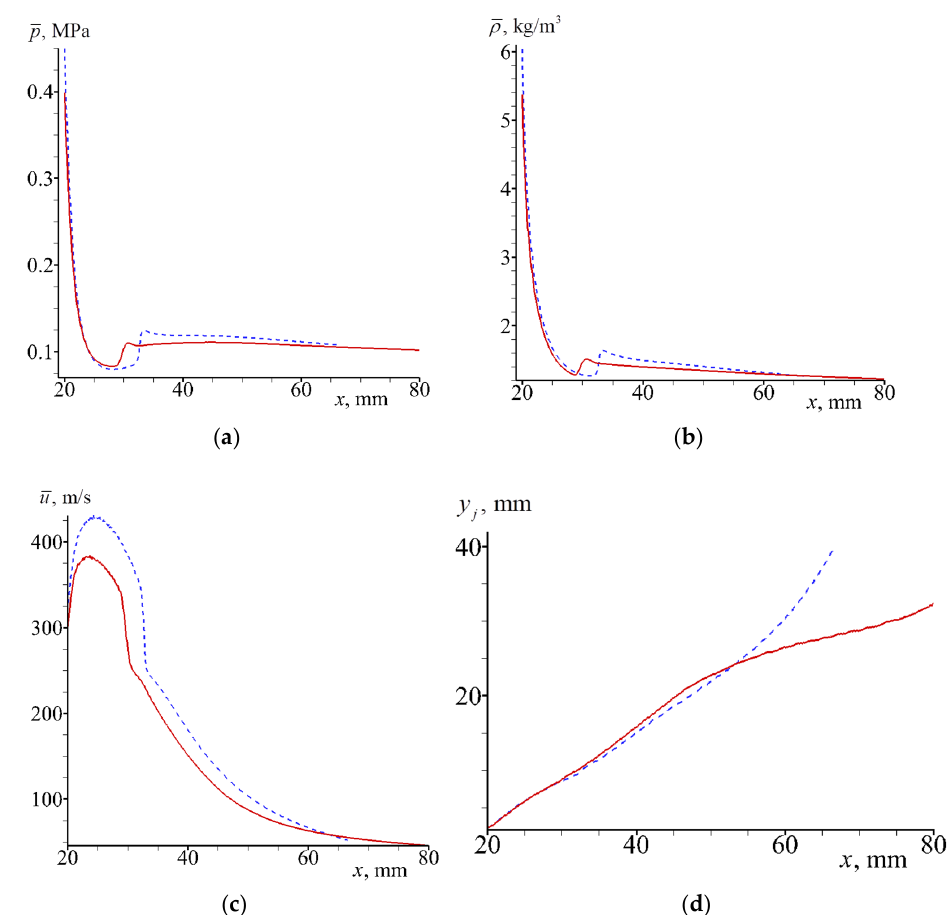
Figure 17. The distribution of average gas parameters in the flow between wide disks: ( a )— p ( x ) ; ( b )— ρ ( x ) ; ( c )— u ( x ) ; ( d )— y j ( x ) . The solid red lines correspond to a two-phase jet of gas–particle mixture, and the dashed blue lines to a gas jet without particles.